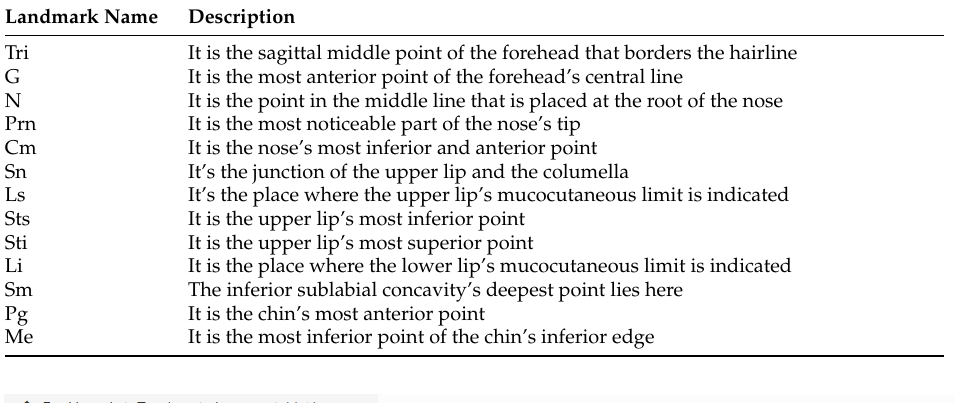
Table 1. The set of soft tissue landmarks.